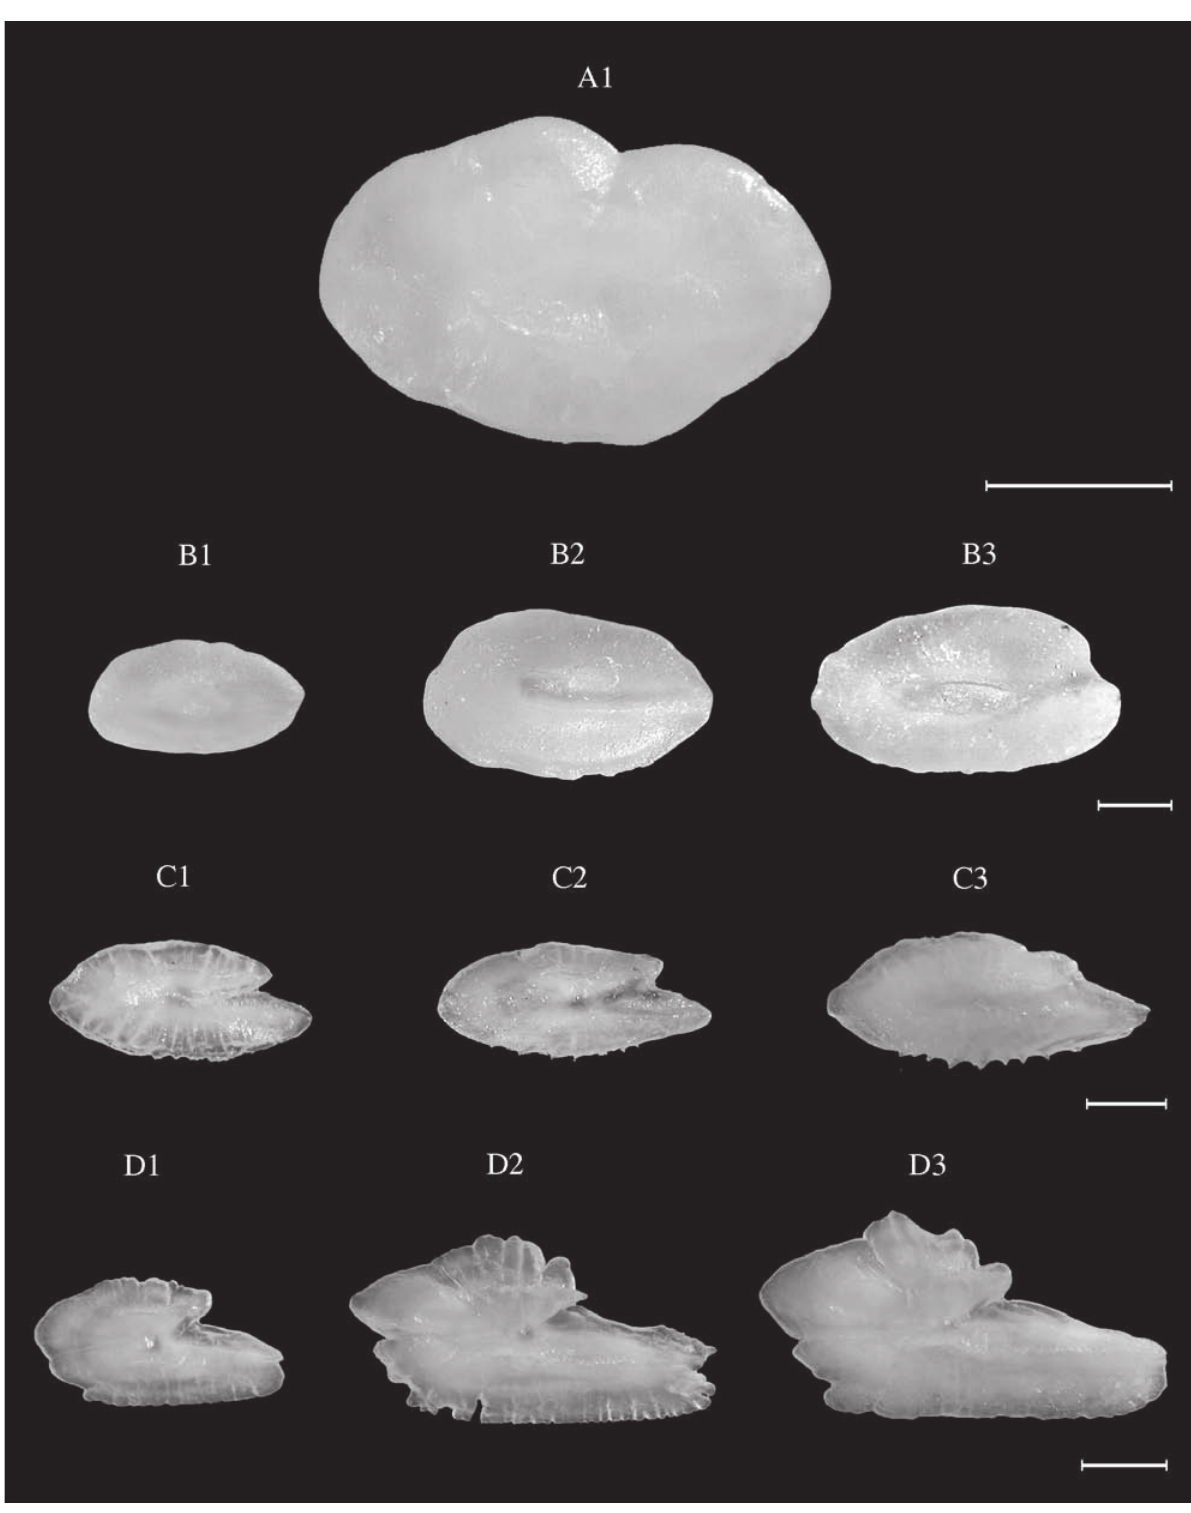
Fig. 15. – Facciolella oxyrhyncha (NEA). TL: A1, 59.0 cm. Nettastoma melanurum . TL: B1, 36.0 cm (NEA) B2, 52.0 cm (WM); B3, 56.0 cm (WM). Engraulis encrasicolus. TL: C1, 13.4 cm (CEA); C2, 15.5 cm (WM); C3, 17.7 cm (NEA). Alosa alosa (NEA) . TL: D1, 25.6 cm; D2, 42.2 cm; D3, 67.5 cm. Scale bar = 1